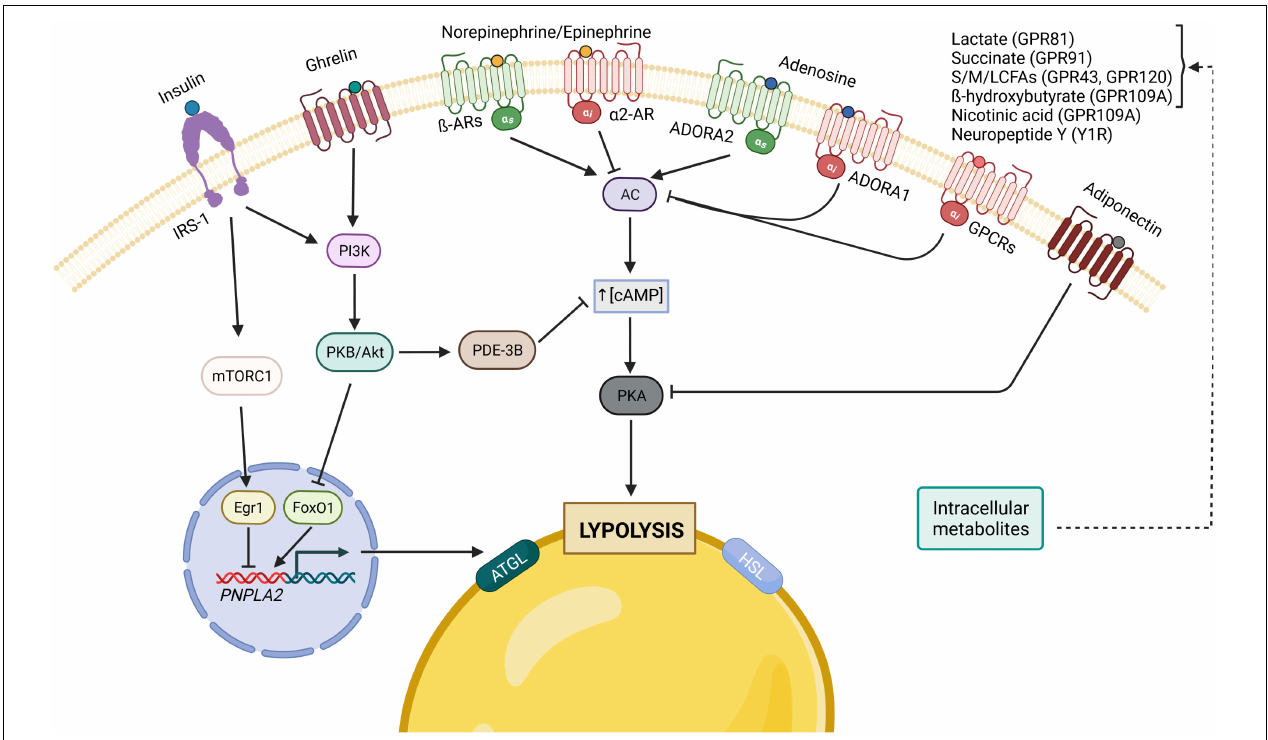
FIGURE 2 | Principal hormonal, autocrine/paracrine modulators of adipocyte lipolysis. The binding of insulin to its receptor, IRS-1, leads to the activation of both PI3K/Akt and mTORC1 pathways, which result in the inhibition of lipolysis, either through the decrease of cAMP levels by PDE-3B (PI3K pathway) or by inhibiting the transcription of ATGL. The gut hormone ghrelin is also considered anti-lipolytic since it stimulates the PI3K pathway as well. Furthermore, lipolysis can also be inhibited by adiponectin, which inhibits PKA, through the reduction of its regulatory subunit of RII α . In contrast, many of lipolysis’ regulators act on the pro-lipolytic PKA pathway, which is typically activated by catecholamines and can be inhibited by different factors upon binding to their respective Gi-coupled receptors. Of note, catecholamines and adenosine can both have pro- and anti-lipolytic effects depending on which receptor is predominantly expressed. AC, adenylyl cyclase; AR, adrenergic receptor; ATGL, adipose triglyceride lipase; cAMP, cyclic adenosine monophosphate; Egr1, Early growth response protein 1; FoxO1, forkhead box protein O1; GPCRs, G-protein-coupled receptors; HSL, hormone-sensitive lipase; IRS, insulin receptor substrate; mTORC1, mammalian target of rapamycin complex 1; PDE-3B, phosphodiesterase 3B; PI3K, phosphoinositide 3-kinase; PKA, protein kinase A; PKB, protein kinase B; NE/E, norepinephrine/epinephrine; ADORA1, adenosine receptor A1; ADORA2, adenosine receptor A2; S/M/LCFA, short-/medium-/long-chain fatty